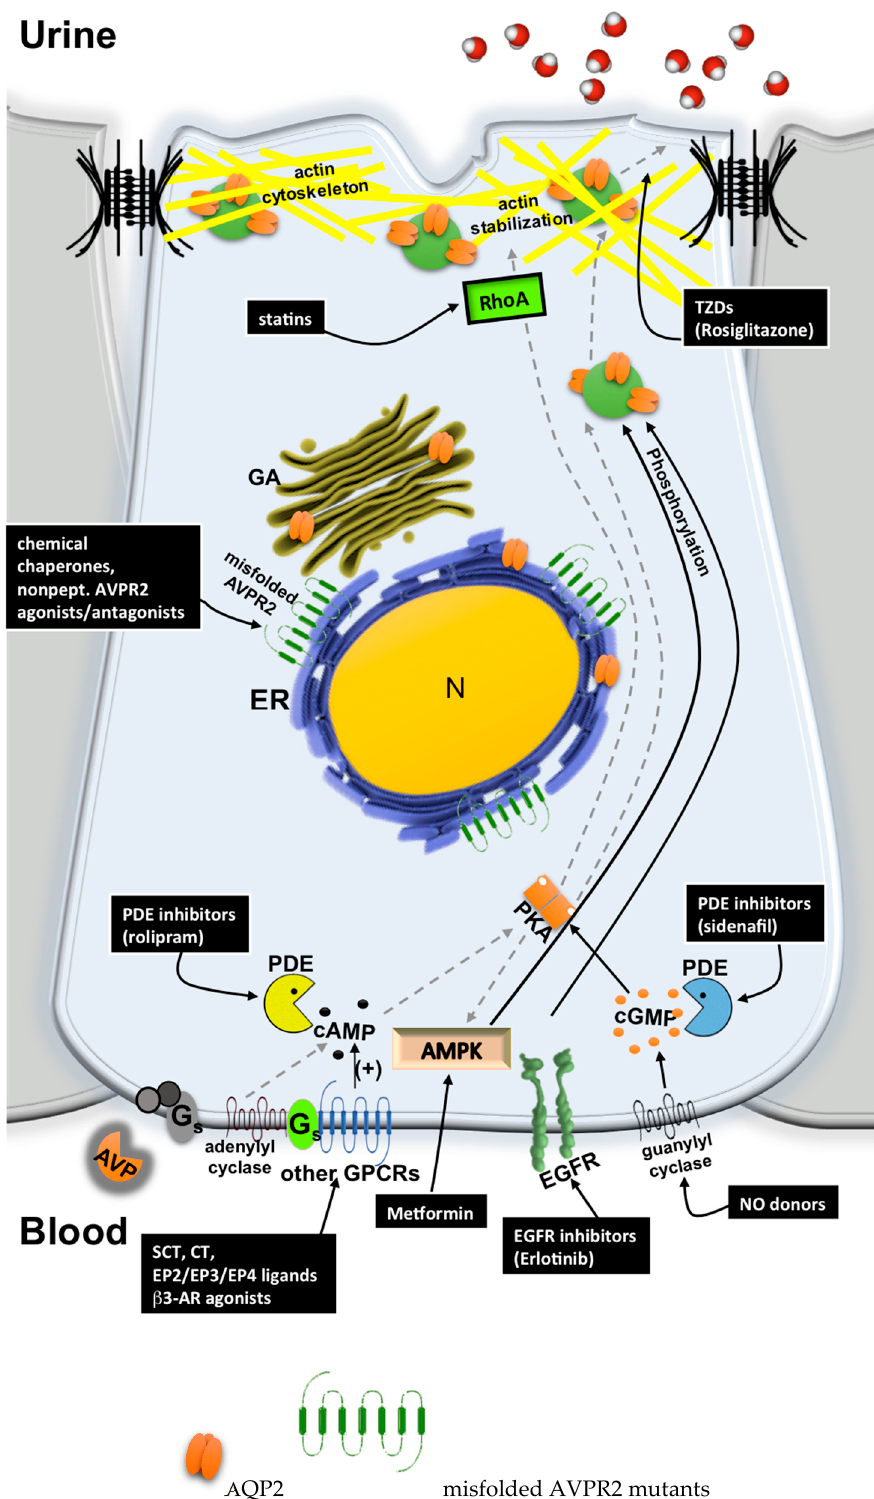
Figure 2. The current possible strategies to bypass AVPR2 mutations responsible for X-linked NDI. The most recurrent mutations of AVPR2 responsible for X-linked NDI are class II mutations producing full-length misfolded proteins trapped in the endoplasmic reticulum (ER), although retaining intrinsic functionality. A lack of AVPR2 basolateral expression prevents AVP signaling and AQP2 exocytosis (grey dotted lines). Possible therapeutic strategies (full lines) for treating X-linked NDI are focused on: (1) the use of chemical chaperones aiding protein folding and inducing export from the ER; nonpeptide AVPR2 antagonists, like vaptans, that stabilize receptor conformation in the